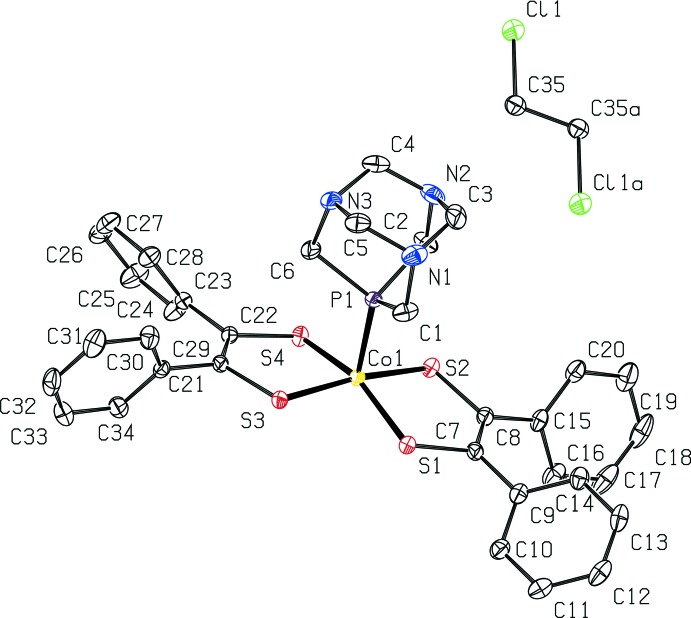
View of [Co(C14H10S2)2(C6H12N3P)]·0.5C2H4Cl2 with 50% probability ellipsoids. H atoms omitted for clarity.